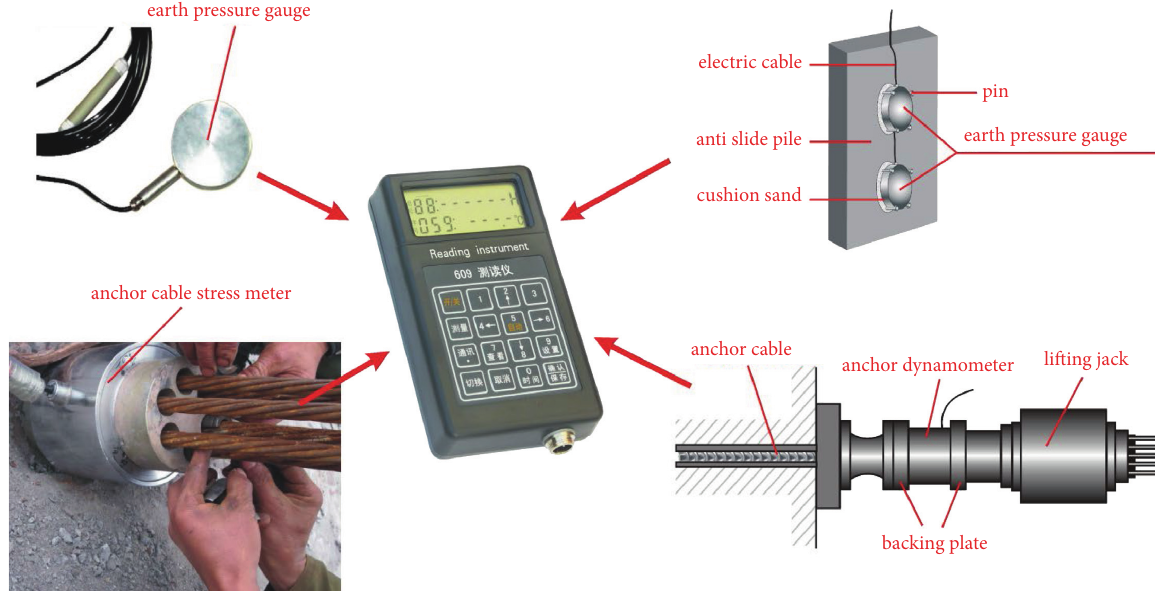
Figure 11: Anchor cable stress